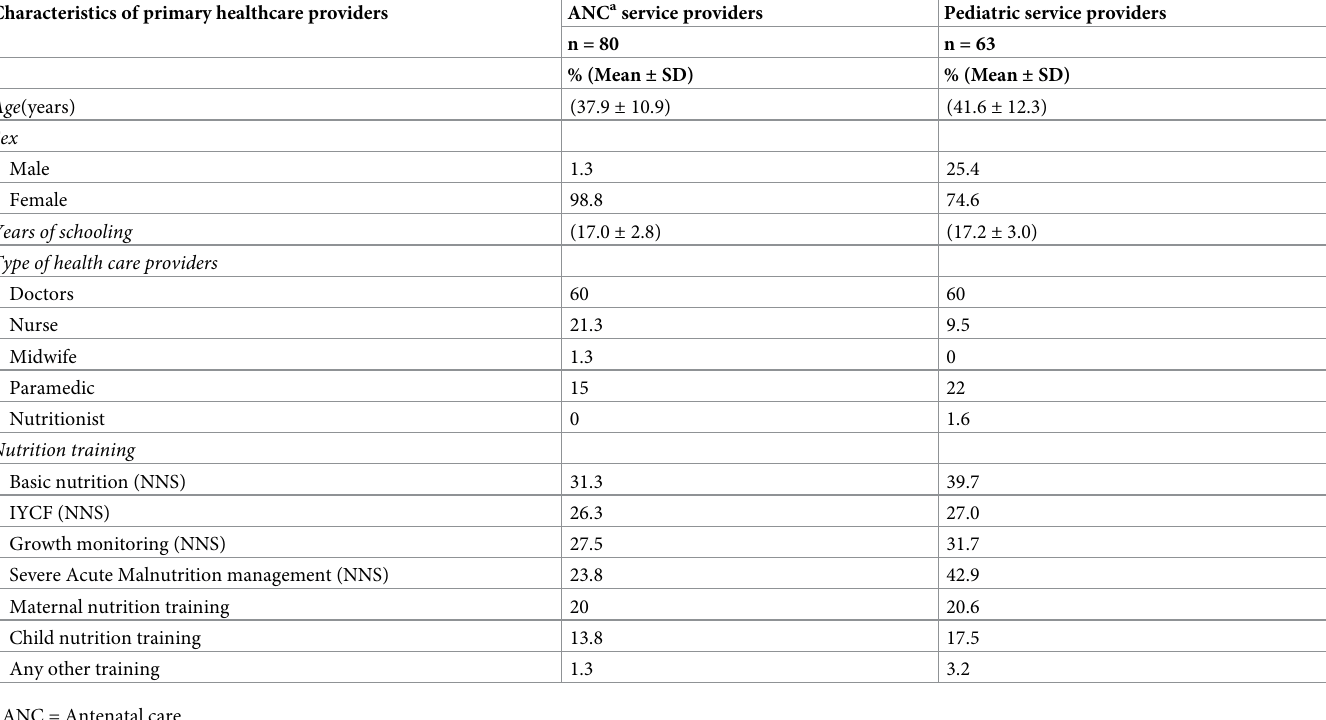
Table 4. Characteristics of primary healthcare